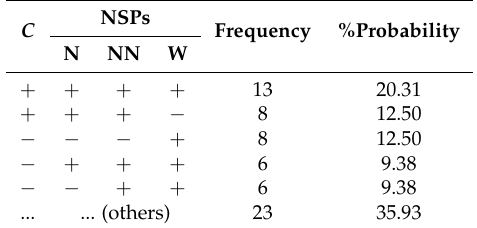
∗ Table 2. Probability distribution of neighbor sign patterns (NSPs) of HL 6 subband (8 × 8 coefficients) in Lena image. In frequency column we show the total occurrences of the corresponding